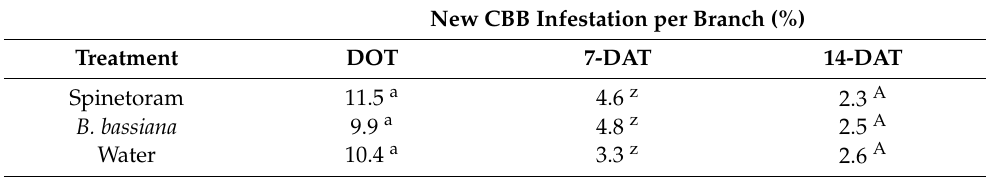
Means with the same letter within a column (different groups of letters for each column) are not statistically different according to the Tukey–Kramer HSD Test ( p > 0.05). Chi-squared, X 2 = 5.91 with 4 d.f., p = 0.21,